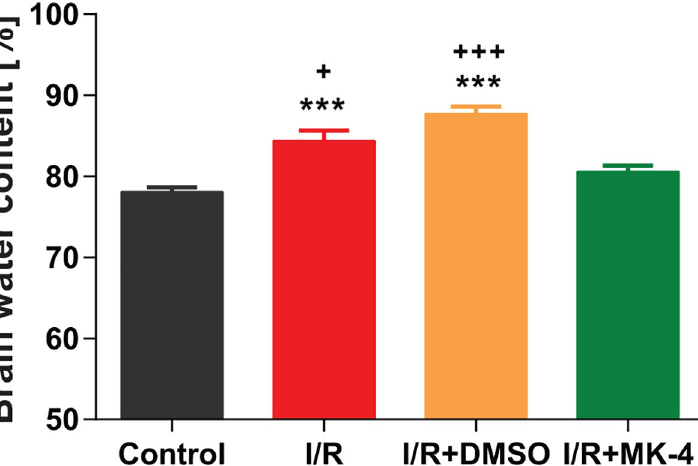
Fig 4. Reduction of brain water content following MK-4 application in I/R rat model. Twenty-four h after I/R injury, brain water content as an index of brain edema was increased. But i.p. MK-4 injection could decrease total brain water content considerably. Data are presented as mean ± SEM. ��� p < 0.001 compared to control, + p < 0.05 and +++ p < 0.001 compared to I/R+MK4 group (n = 6).